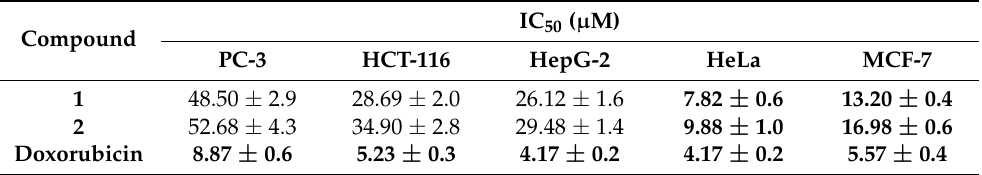
Table 7. In vitro anti-proliferative activity of compounds 1 and 2